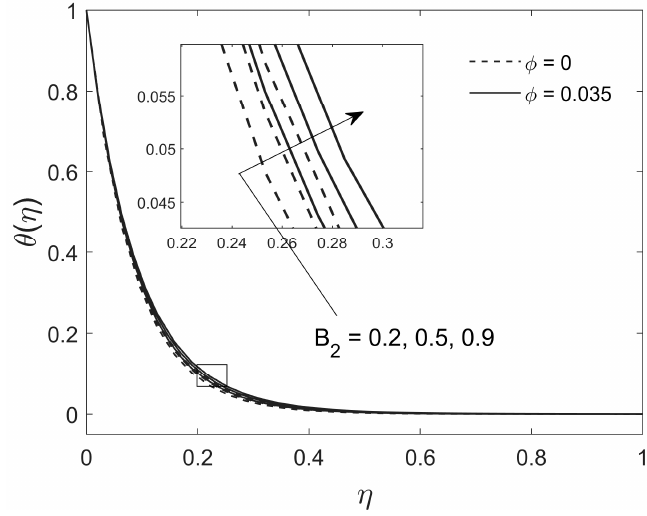
Figure 10. Effect of the slip on the temperature distribution.